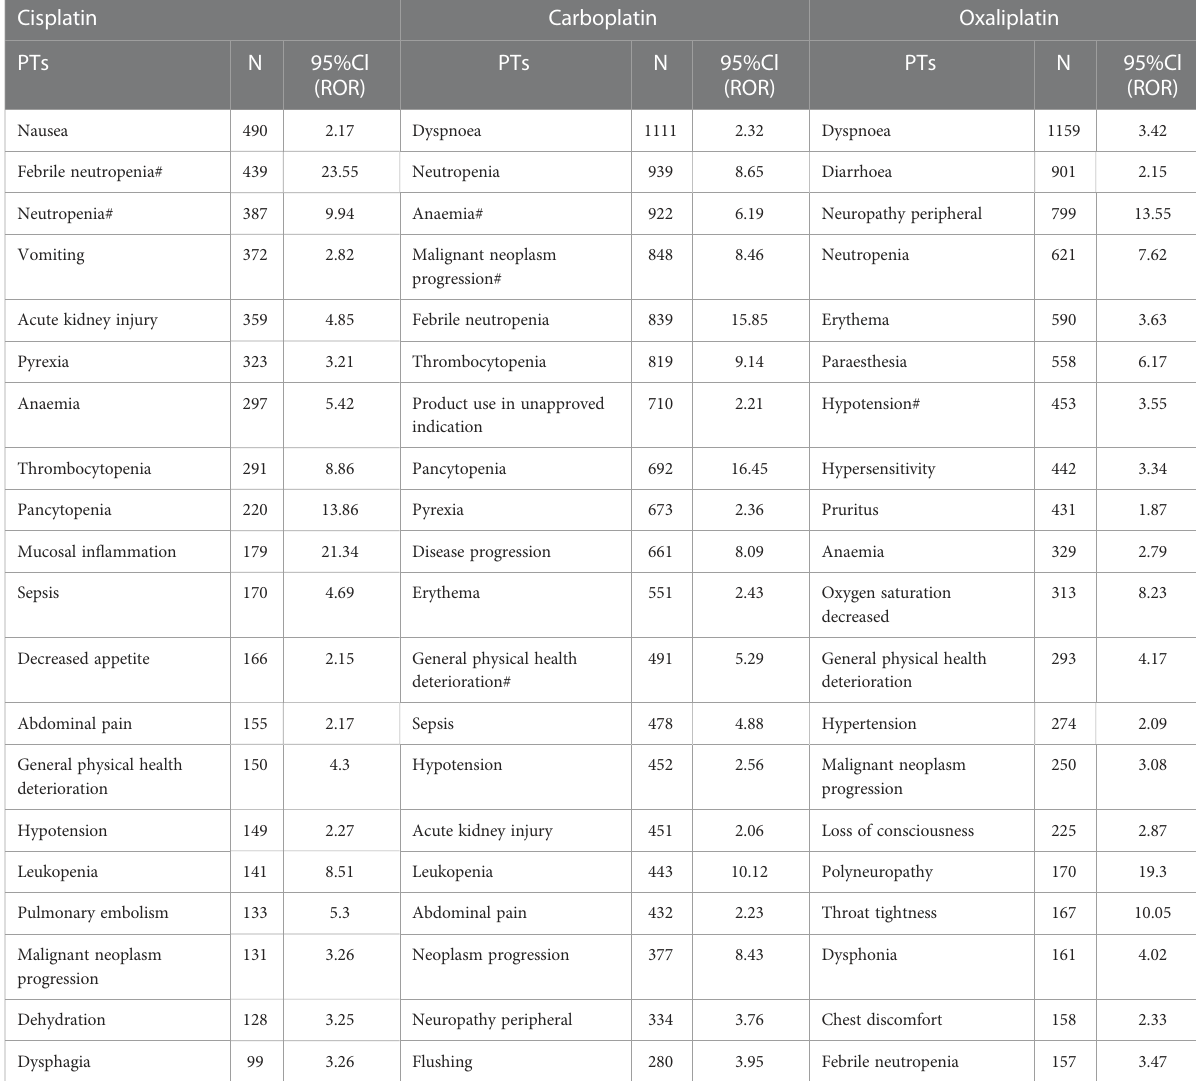
TABLE 2 The top 20 ADE signals of Cisplatin, Carboplatin and Oxaliplatin. Cisplatin